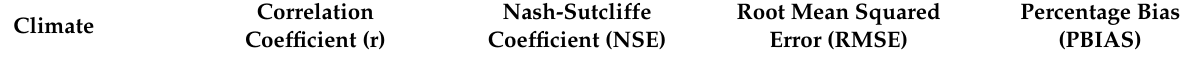
Table 4. Range of values of statistical indicators obtained in validation of the two novel methods with the two-parameter input combination using data from 32 synoptic weather stations in Iran.